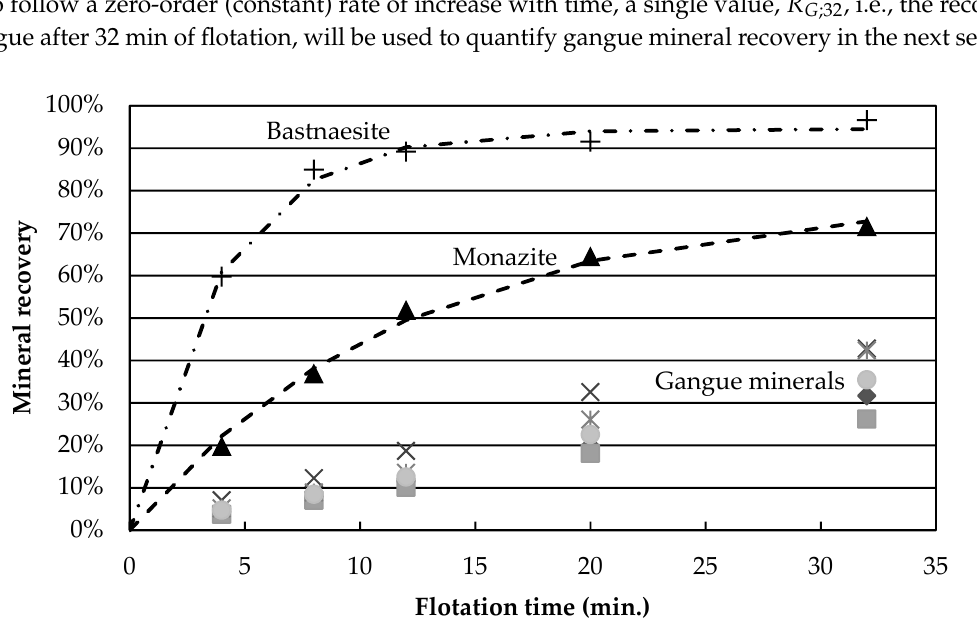
Figure 6. Measured (points) and modelled (lines) for test 7 (central point).